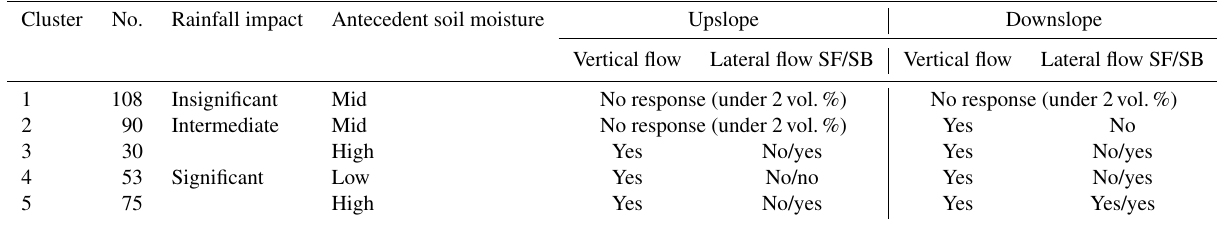
Table 3. Combinations of flow paths and its hydrologic conditions for all clusters. Cluster No. Rainfall impact Antecedent soil moisture Upslope Downslope Vertical flow Lateral flow SF/SB Vertical flow Lateral flow SF/SB Insignificant Mid No response (under 2vol.%) No response (under 2vol.%) Intermediate Mid Significant